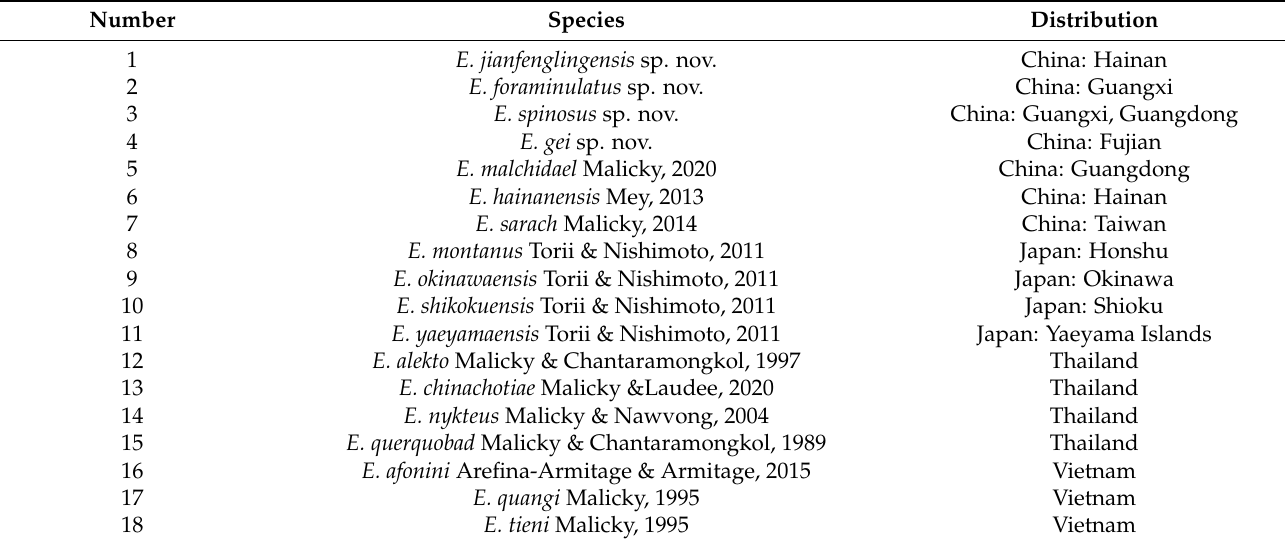
Table 1. World list of Eoneureclipsis species.